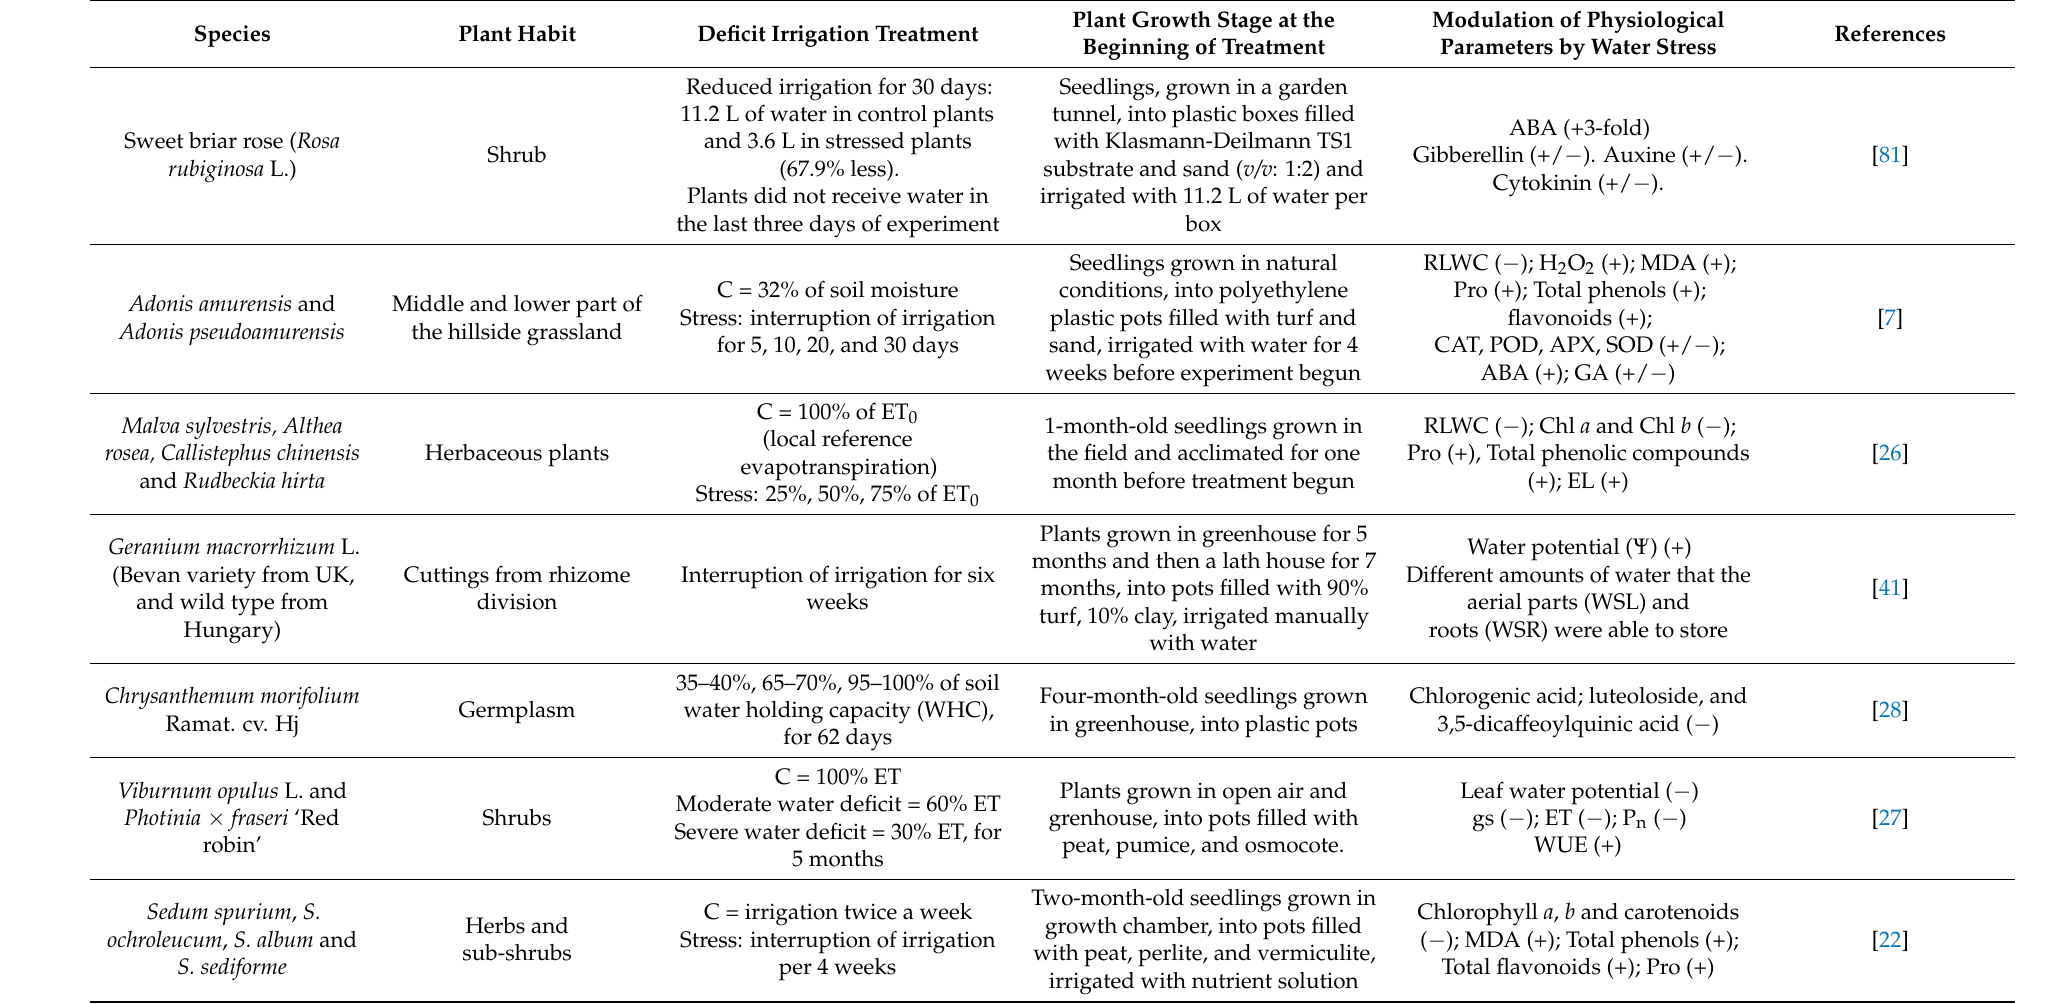
Table 2. Effect of water stress on physiological parameters of ornamentals